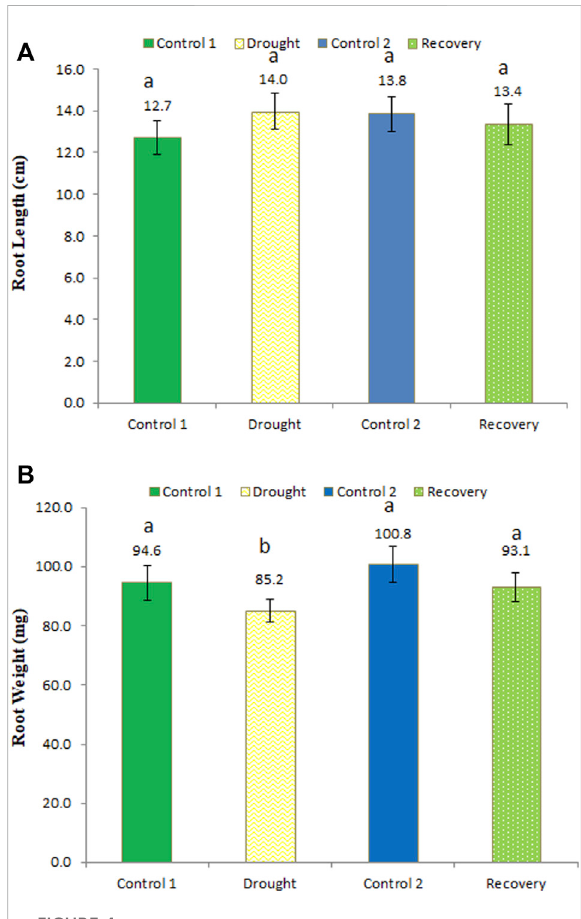
FIGURE 4 Effect of drought stress on the root length (A) and weight (B) of wheat and its recovery after drought stress. Length is measured in centimeters and weight in milligrams. The data represent the mean of three independent replications. Different letters above the column indicate signi fi cant changes when determined through Tukey ’ s HSD